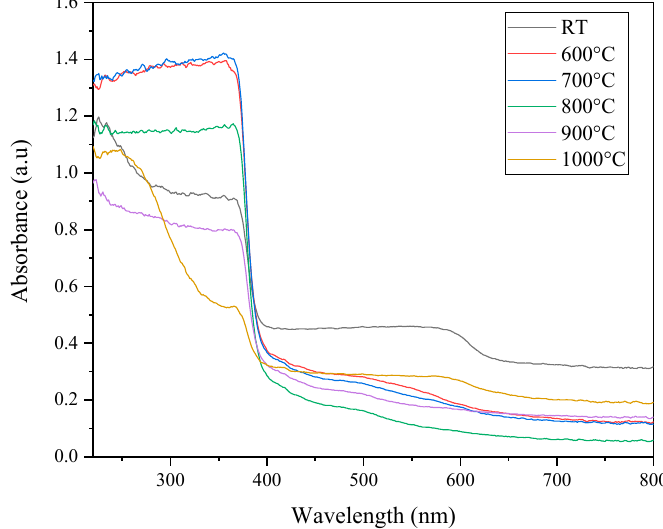
Optical absorbance spectra for the ZnO-SiO 2 composite sintered at di ff erent